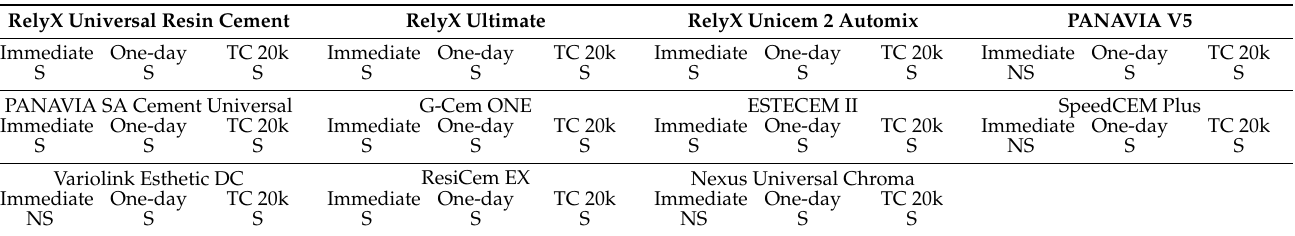
Table 10. Comparison of the results (by t -test) for flexural strength of each adhesive resin cement material with regard to two curing